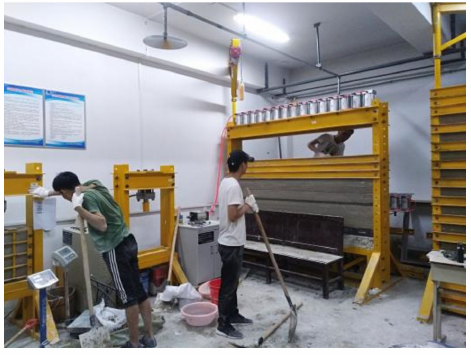
Figure 4. Laying process of the physical analog model.